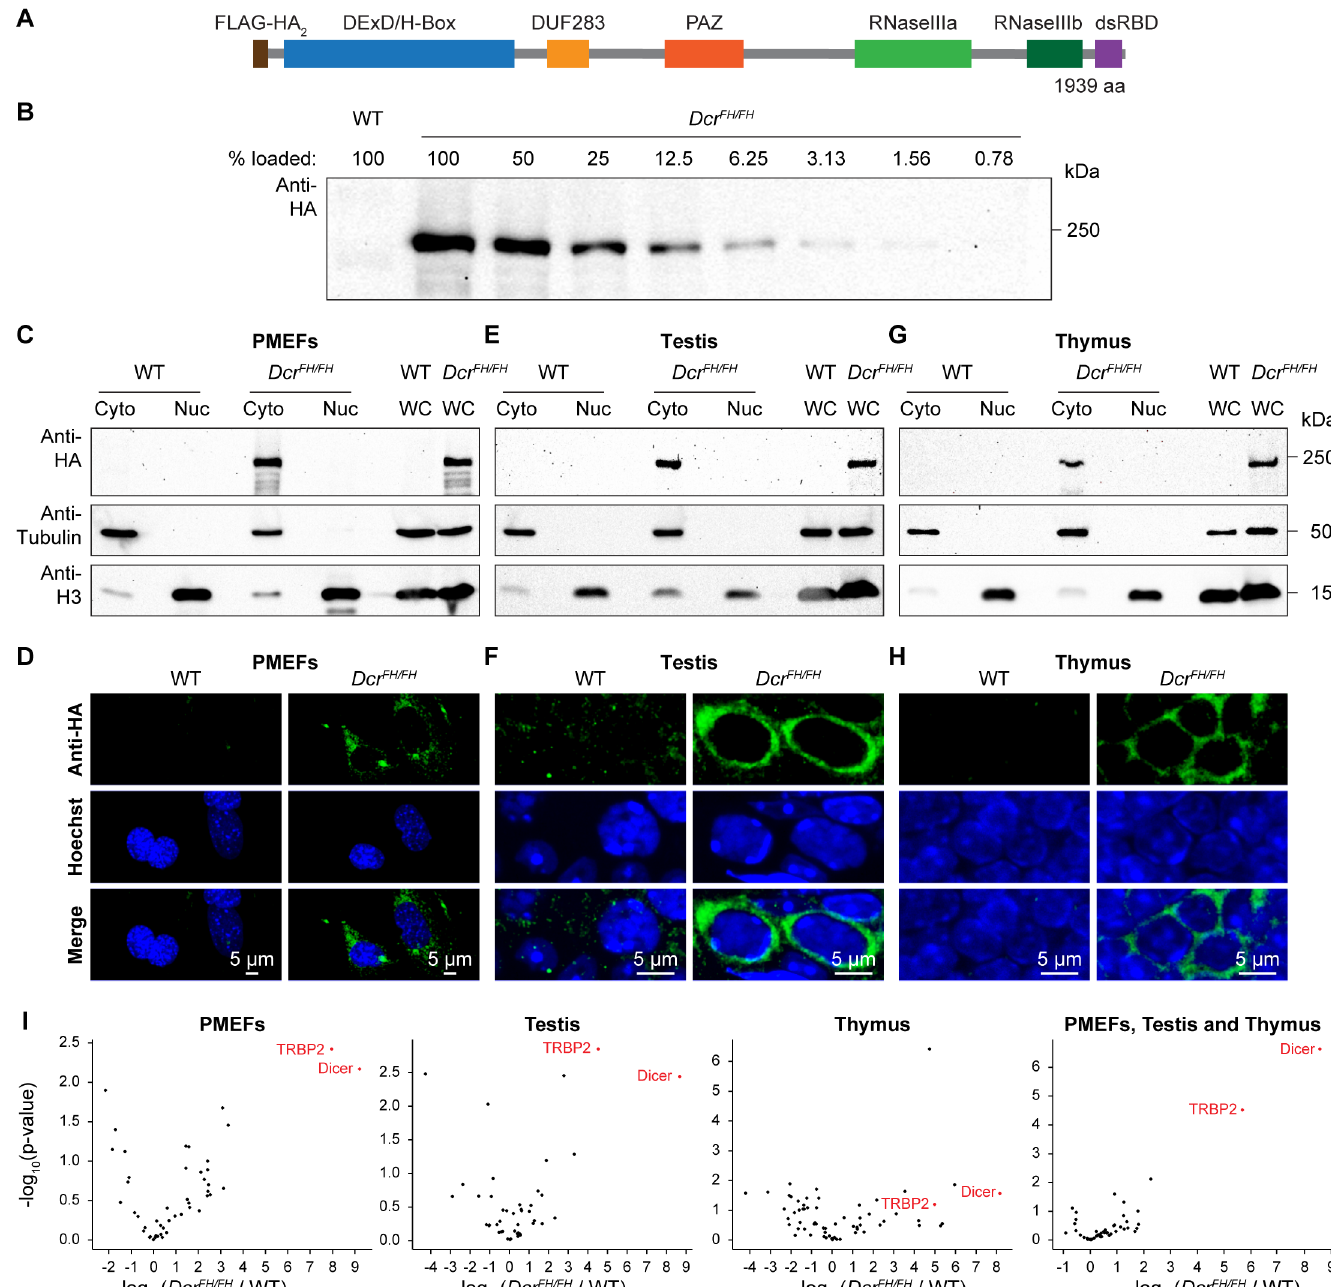
Fig 1. Dicer localizes exclusively to the cytoplasm of embryonic fibroblasts and adult tissues. (A) Schematic representation of the domain structure of N-terminal Flag-HA 2 tagged murine Dicer. (B) Western blot using anti-HA antibody on serial dilution of whole cell extract from Dcr FH/FH PMEFs. (C, E and G) Western blot analysis after subcellular fractionation using anti-HA antibody on cytoplasmic (Cy), nuclear (Nu) and whole cell (WC) extracts from wild type and Dcr FH/FH PMEFs (C), adult testis (E) and thymus (G). Tubulin served as a cytoplasmic marker and histone H3 as a nuclear marker. (D, F and H) Confocal immunofluorescence micrographs showing wild type and Dcr FH/FH PMEFs (D) as well as sections of adult testis (F) and thymus (H) stained with anti-HA antibody. Nuclei are stained with Hoechst. Scale bars represent 5 μ m. (I) Immunoprecipitation using anti-HA beads and mass spectrometry analysis of the Dicer interactome in PMEFs, testis and thymus (each biological duplicates) and all of them pooled (six biological